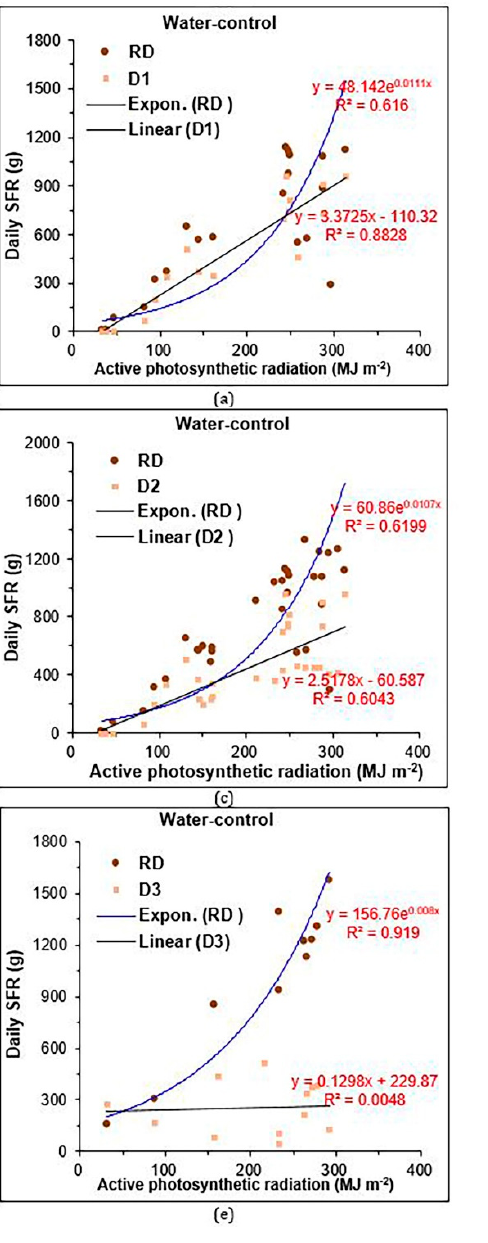
Figure 6. Comparisons of relationships between daily SFR (sap flow rate) and active photosynthetic radiation before and after irrigation. ( a ) RD and D1 during water-control; ( b ) RD and D1 after irrigation; ( c ) RD and D2 during water-control; ( d ) RD and D2 after irrigation; ( e ) RD and D3 during water-control; ( f ) RD and D3 after irrigation.